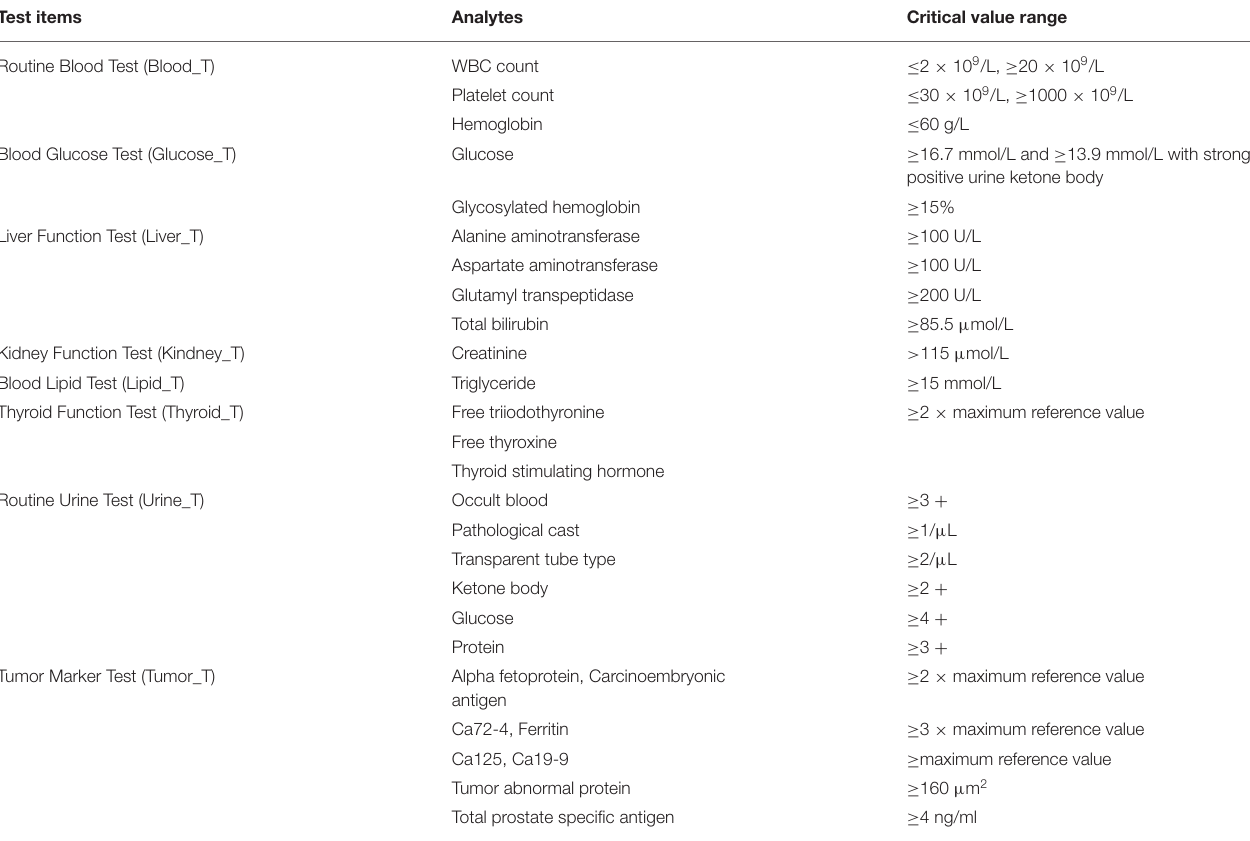
TABLE 1 | The critical value list in health checkup for a laboratory test.